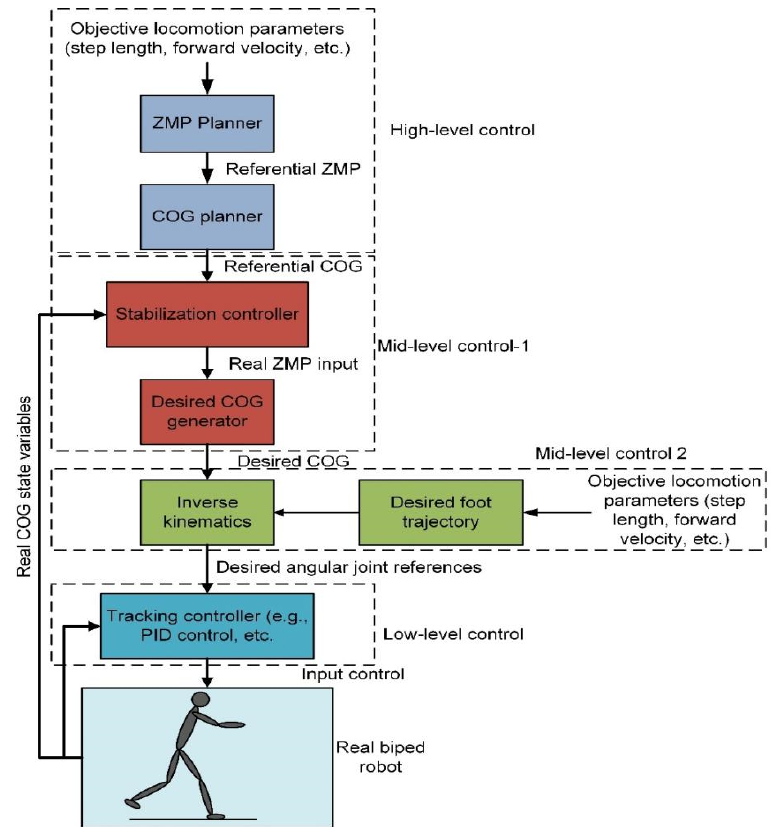
Figure 2. Multi-level control architecture with four control layers: High-level control, Mid-level control 1, Mid-level control 2, Tracking low-level control.